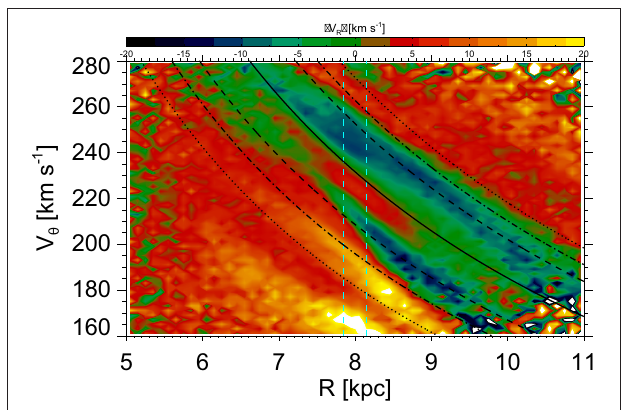
FIGURE 8 | R – V θ plane of Gaia stars with the mapping of the mean value of the radial velocity V R , calculated in bins of 0.1kpc × 2.0kms − 1 . The pattern of diagonal ridges can be recognized in the distribution of mean V R . The black lines indicate families of orbits with constant angular momentum L z associated with spiral resonances: solid for the CR, dotted for the 6/1 ILR (lower) and OLR (upper), dot-dashed for the 8/1 ILR (lower) and OLR (upper), and dashed for the 12/1 ILR (lower) and OLR (upper). The vertical cyan dashed lines enclose the radial range used for the construction of the observed U – V plane of the SN from Gaia stars shown in Figure 7A .